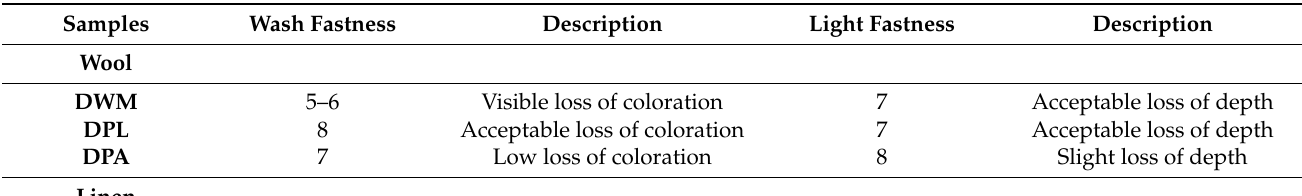
Table 10. Wash and light fastness values for the colored